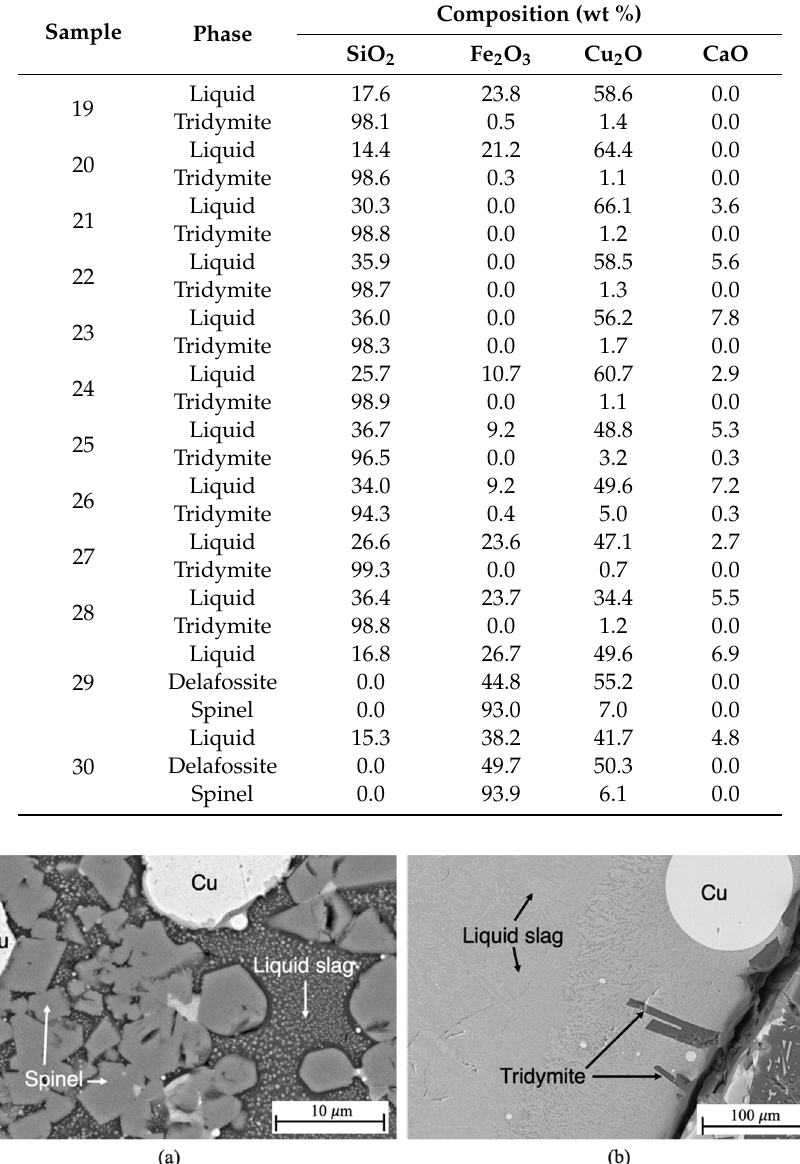
Table 3. Phase compositions determined experimentally for the Cu 2 O–Fe 2 O 3 –SiO 2 –CaO system in equilibrium with metallic copper at 1200 °C.